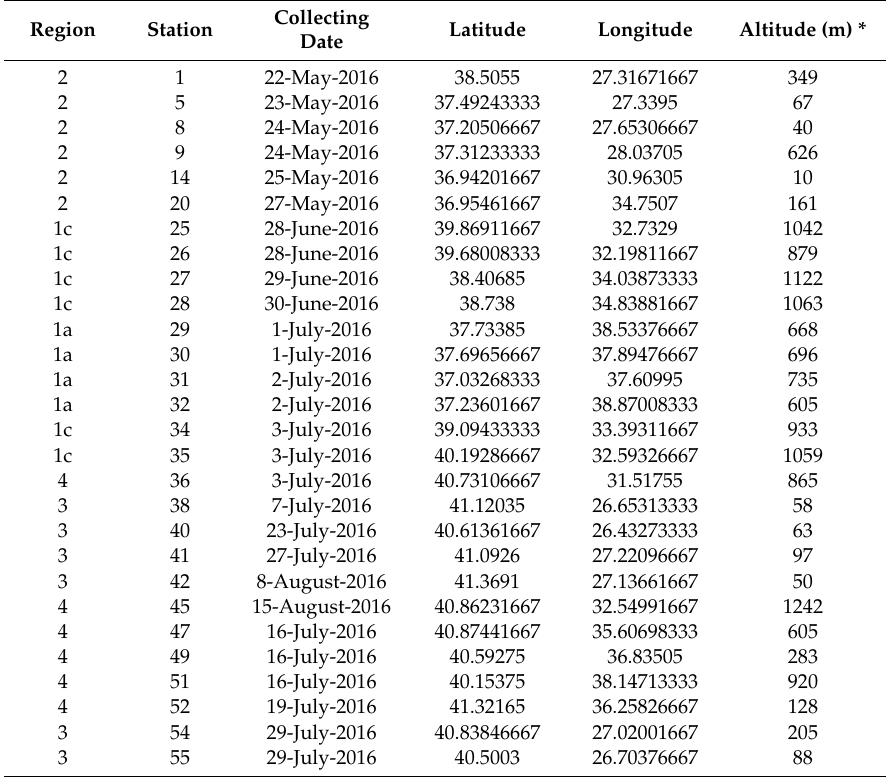
Table 1. Geographical origins of Brachypodium accessions used in this study (sorted by collecting date).